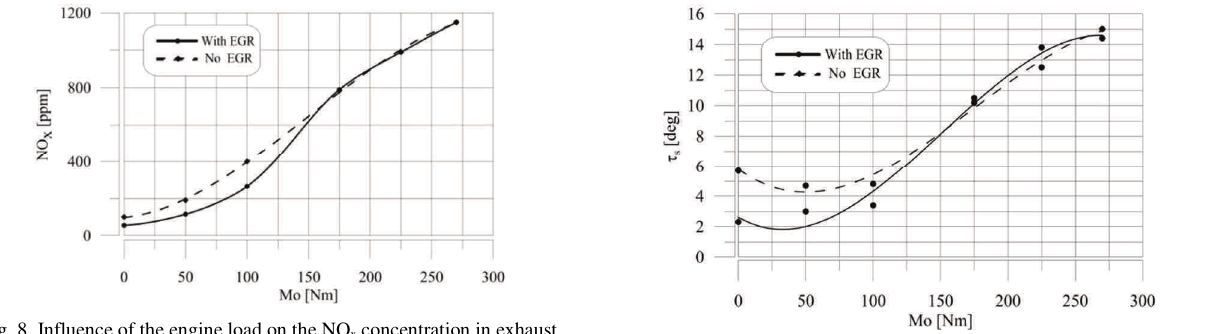
Fig. 11. Influence of the engine load delay of self-ignition t s for engine operating with/without EGR